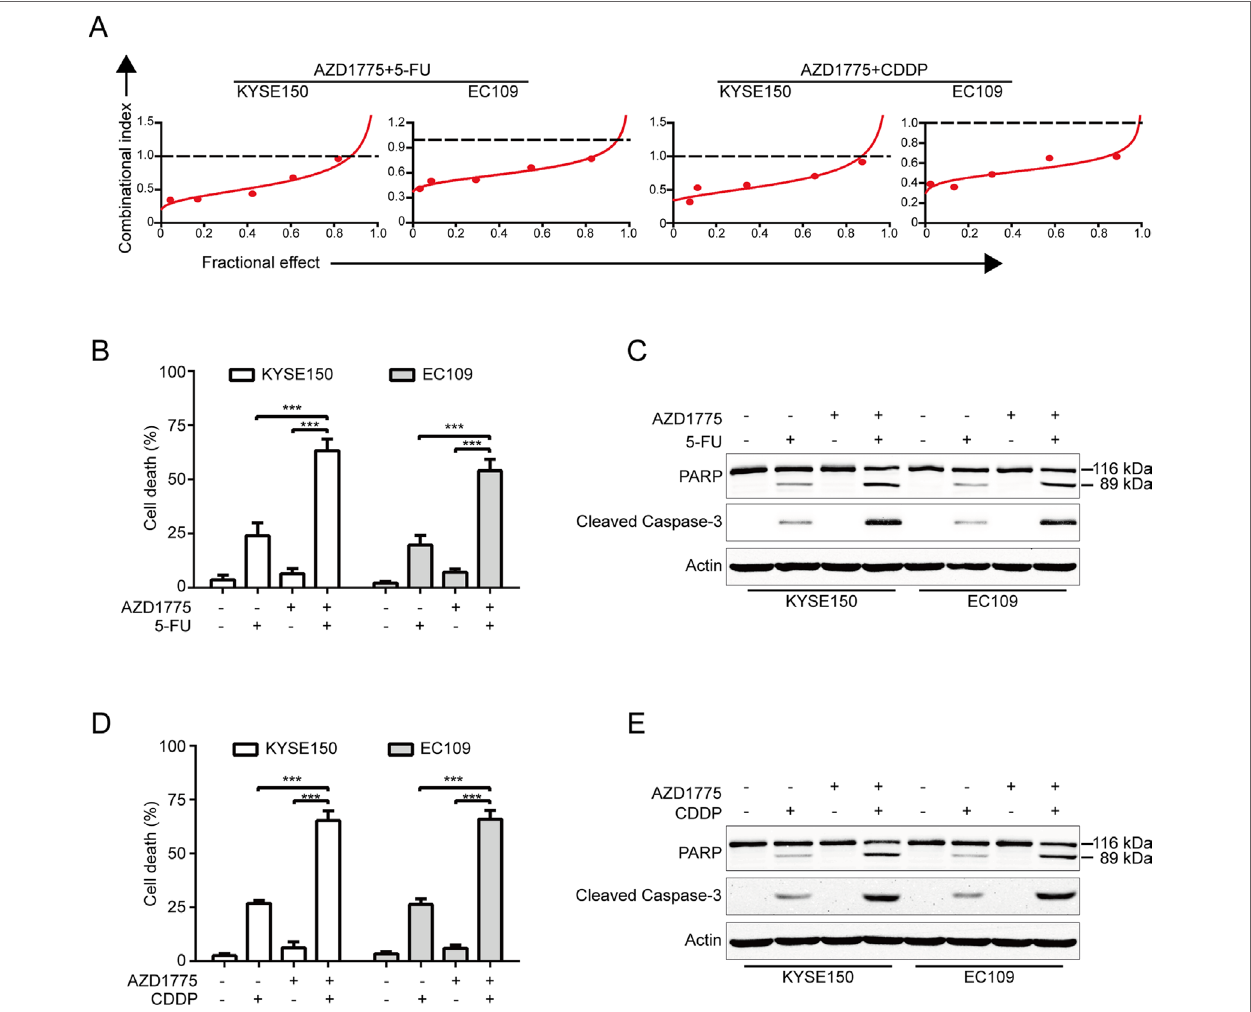
FIGURE 6 | AZD1775 is Synergistic with Cisplatin and 5-FU. (A) KYSE150 and EC109 cells were treated with a serially diluted mixture (a fixed ratio) of AZD1775 and CDDP or 5-FU for 72 h; the cell viability was examined by MTT assay. Synergistic effect was estimated using the median-effect method of Chou and Talalay. The combination index (CI) was the ratio of the combination dose to the sum of the single-agent doses at an isoeffective level. The dashed dotted line indicates CI = 1. CI < 1 indicate synergism between the two drugs. (B) and (D) KYSE150 and EC109 cells were exposed to AZD1775 (0.25 μM) with combination of 250 μM 5-FU or 10 μM CDDP for 48 h and then examined with a hemocytometer by trypan blue exclusion assay ( n = 6 per group). Column, mean; error bar, SD. (C) and (E) The cleavages of PARP and caspase-3 were detected by Western blotting analysis. *** P < 0.001, one-way ANOVA with post-hoc intergroup comparison with Tukey’s